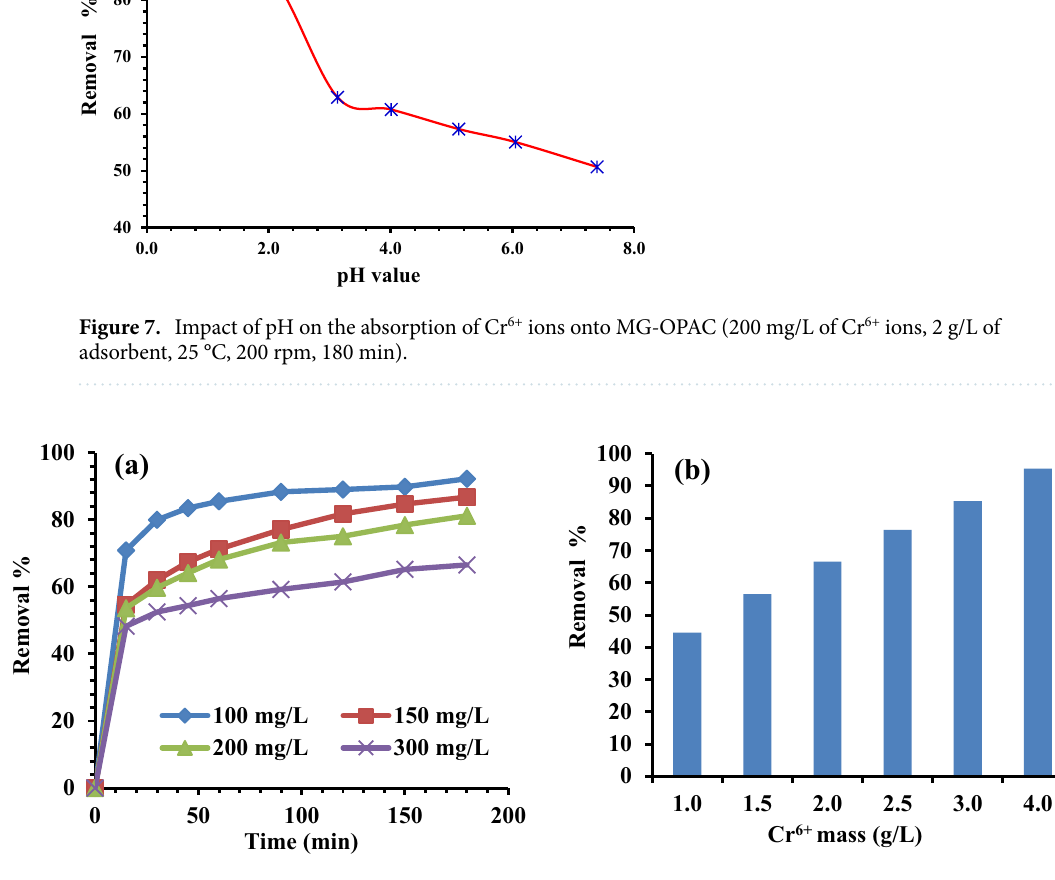
Figure 8. ( a ) Impact of time of contact on the absorption of varied starting concentrations of Cr 6+ by 2 g/L of MG-OPAC, ( b ) Influence of the MG-OPAC doses on the absorption of Cr 6+ ions, 200 rpm, 25 °C and pH 1.3.